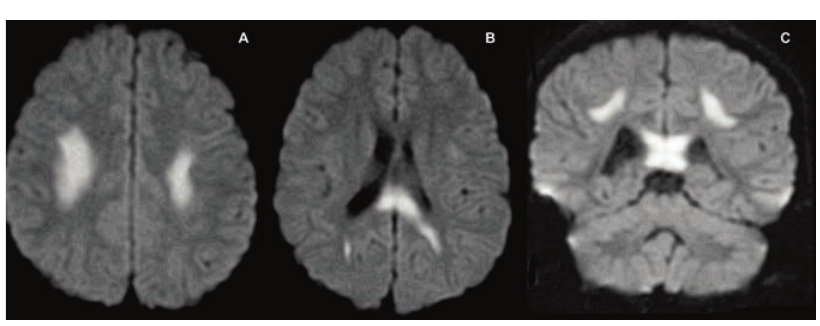
Figure 2. Brain magnetic resonance imaging (MRI) with diffusion-weighted images (DWI) shows the presence of high signals in the bilateral cerebral deep white matter (A; axial), at the splenium of the corpus callosum (SCC) (B; axial), and both (C; coronal) of the younger twin (Patient 2). Follow-up brain MRIs performed one month later showed complete resolution of SCC but the presence of small remaining lesions in the deep white matter (data not